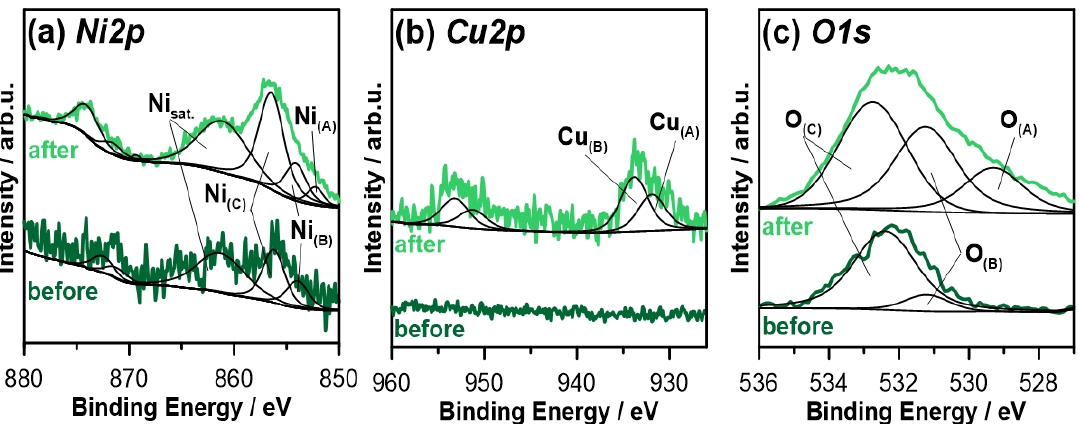
Figure 9. High-resolution XPS spectra recorded for blank Ni coating in ( a ) Ni2, ( b ) Cu2p, and ( c ) O1s peak binding energy range, before and after the exposure to 0.05 M NaCl.